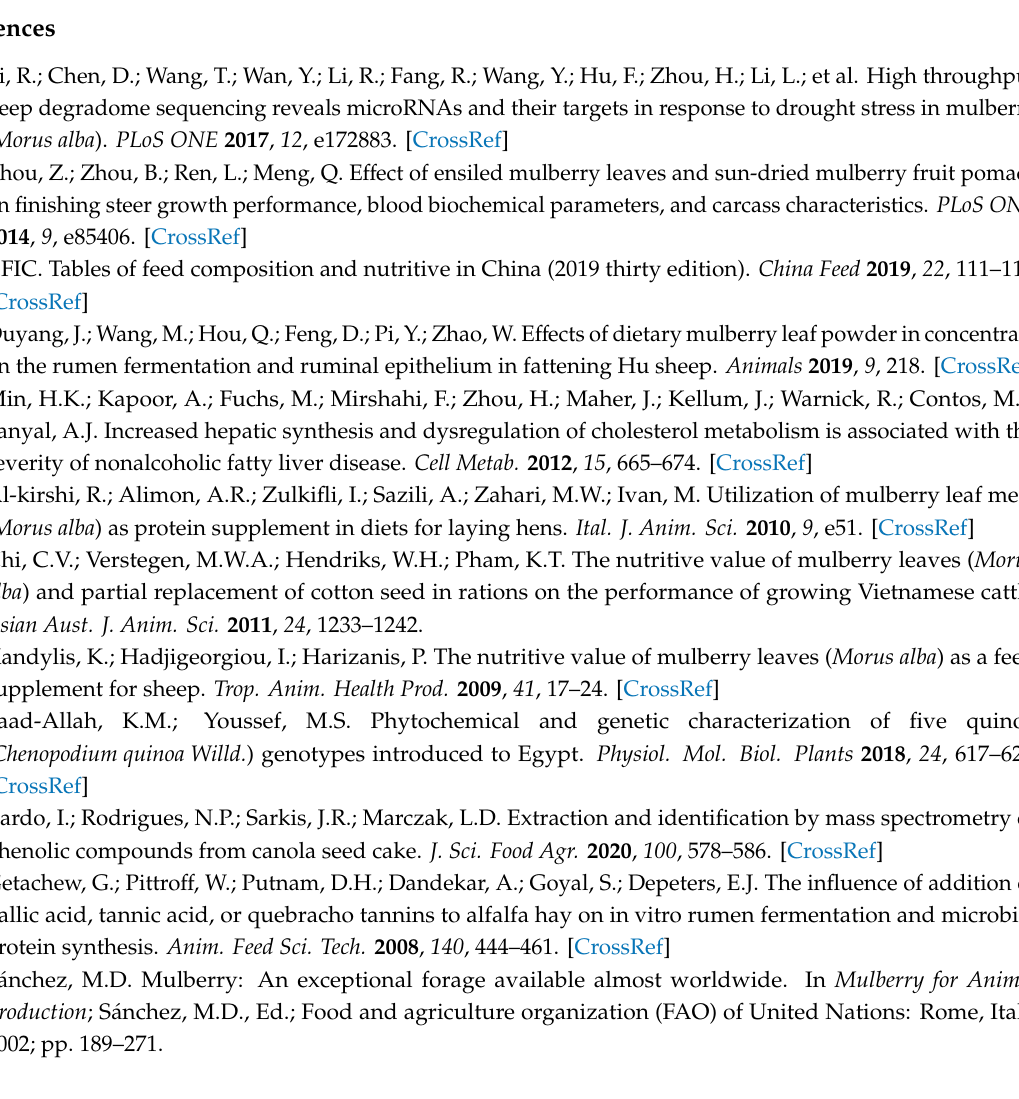
Figure S1: Heatmap showing the relative abundances of dominant genera; Table S1: Composition and nutrient contents of the experimental diets (%); Table S2: Real time-PCR primers used in this study; Table S3: Diversity estimation based on the 16S rRNA gene libraries for each sample from the sequencing analysis; Table S4: Number of OTUs and diversity estimates based on the 16S rRNA gene libraries from the sequencing analysis; Table S5: The 10 most abundant phyla in the rumen bacteria of goats; Table S6: Distribution of genera in di ff erent groups; Table S7: Predicted functions at level 1 of the rumen bacterial microbiota; Table S8: Predicted functions at level 2 of the rumen bacterial microbiota; Table S9: The relationships among bacterial genera, environmental parameters and serum biochemical indices; Table S10: Correlations among the rumen morphological parameters, rumen fermentation parameters, CMCase activity and selected microbiota a ff ected by di ff erent feed types. Author Contributions: Conceptualization, Y.Y. and Y.C.; methodology, Y.W.; software, Y.W. and Q.S.; formal analysis, Y.W., Q.S., and S.Z.; writing—original draft preparation, Y.W.; writing—review and editing,